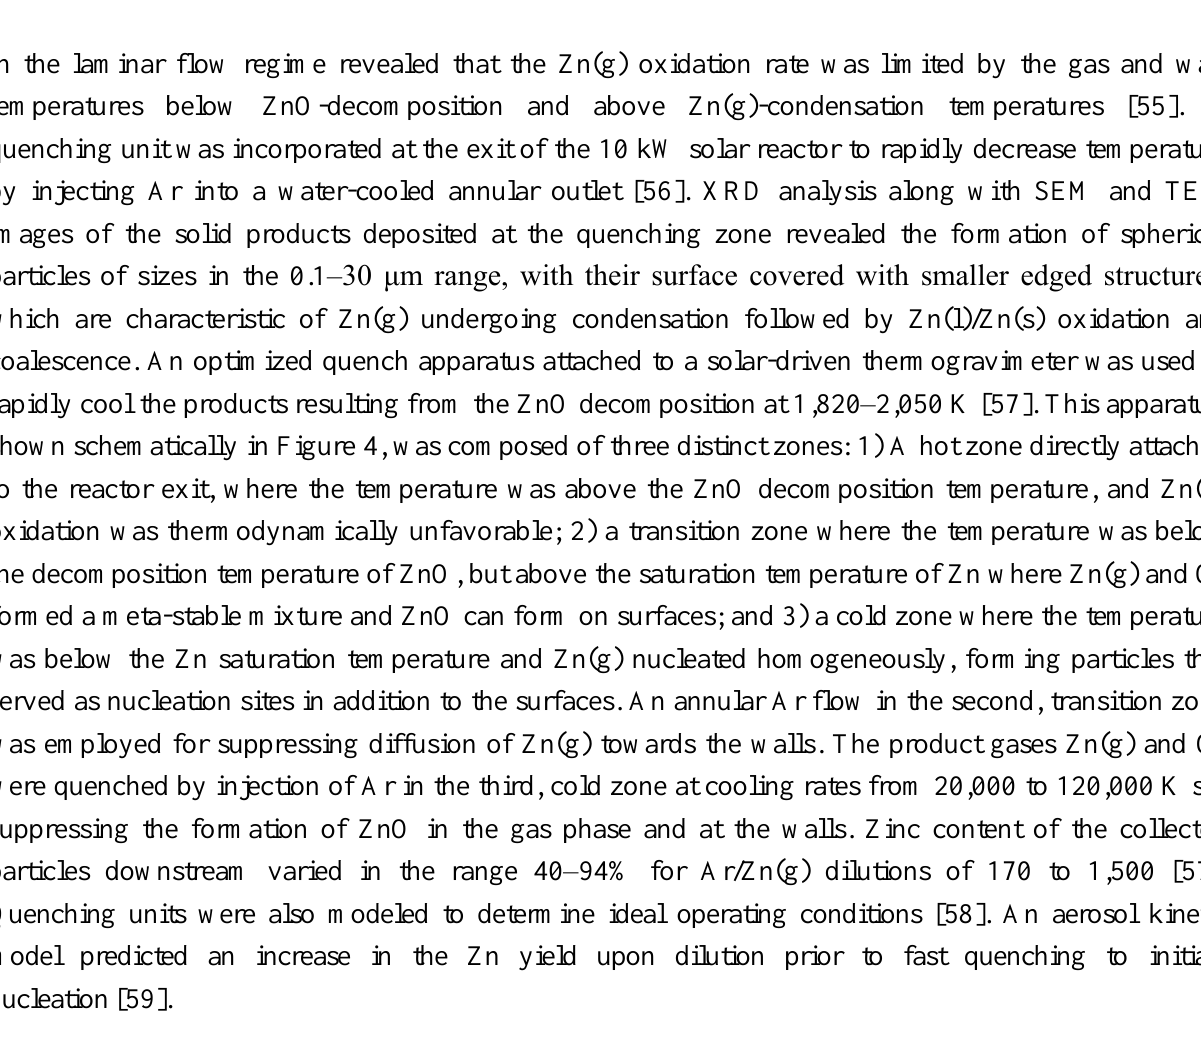
Figure 4. Schematic of the quench apparatus illustrating the three temperature zones